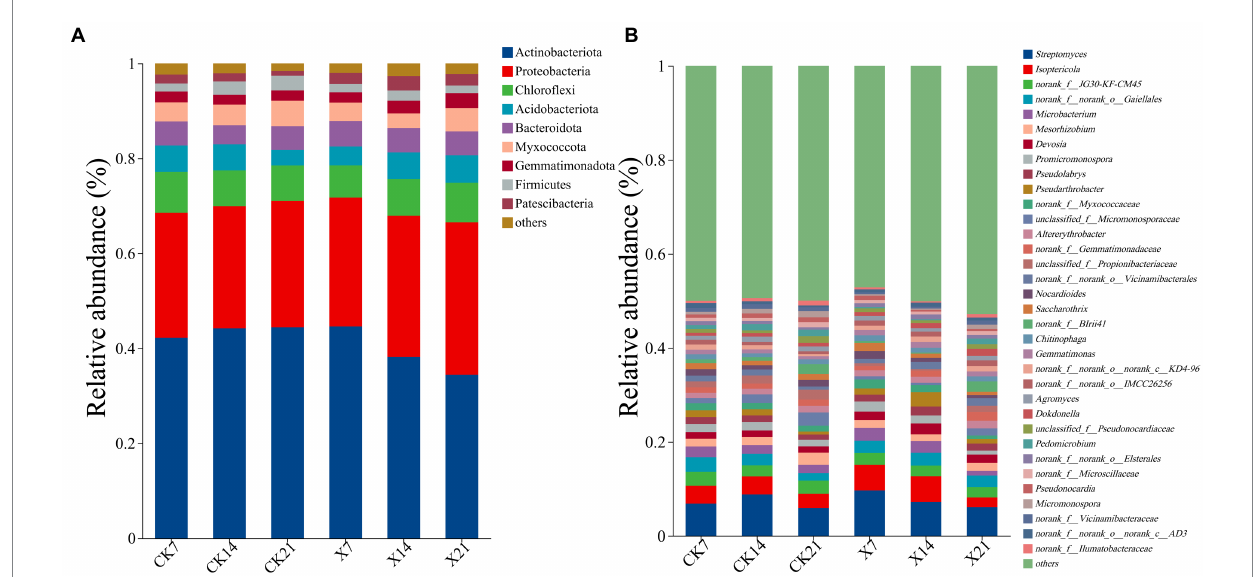
FIGURE 8 Bacterial flora composition at phylum and genus levels. (A) Phylum level. (B) Genus level, genera with relative abundance less than 1% are classified as other. X refers to C. cateniannulata X8 treatment, CK refers to the control, and the number indicates the time point after inoculation.